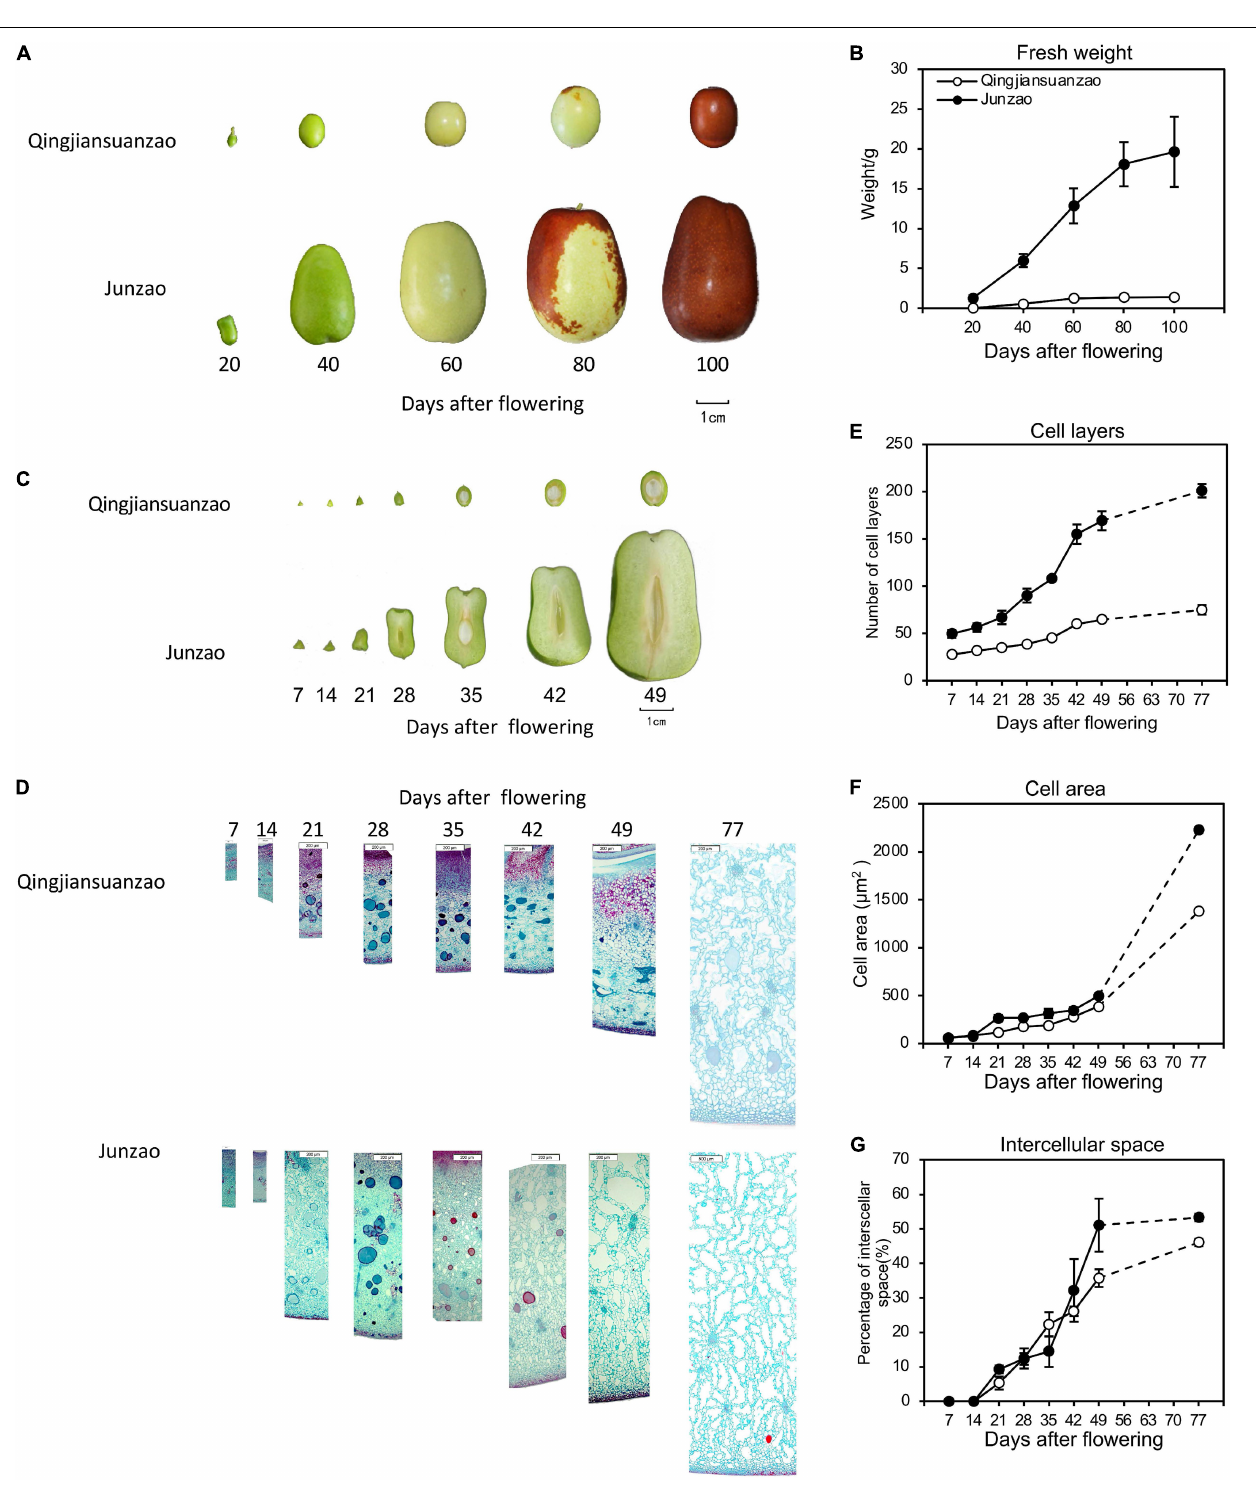
Frontiers in Plant Science |